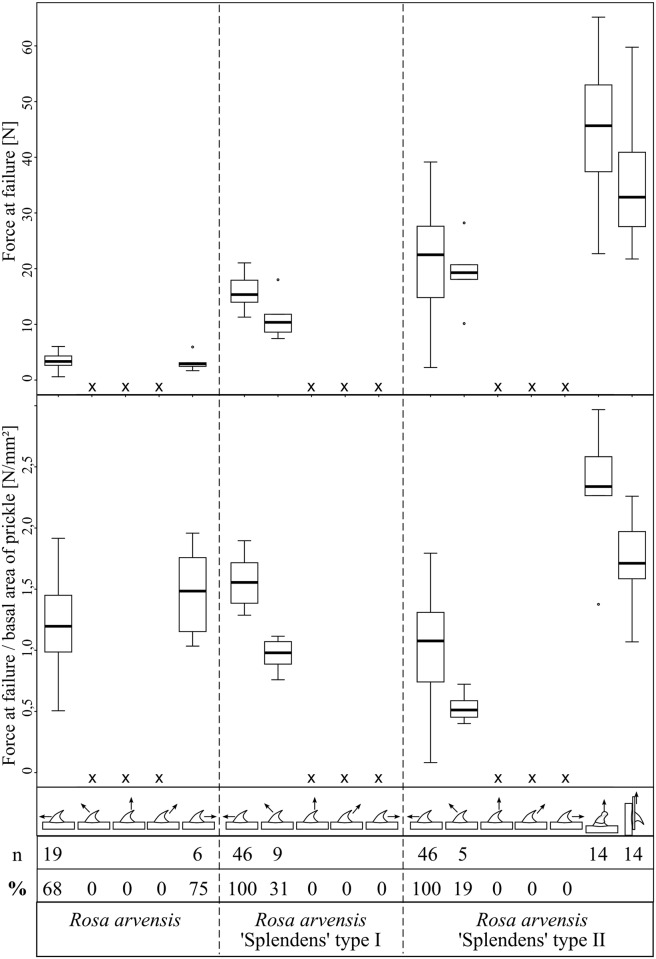
Maximum force and maximum force/basal area measured at failure of the tested rose prickles.In the illustrations of force direction the stem apex is situated on the left and the stem base on the right. x indicates that testing with a traction force in this direction was not possible due to slippage of the Kevlar loop. Numbers below indicate the number (n) and percentage (%) of samples having failed in the mechanical tests. In long axes type II of Rosa arvensis ‘Splendens‘ prickles were additionally tested in tension, with the prickle tested perpendicular to the stem, and in shear with the prickle tested parallel to the main axis of the stem (on the right).